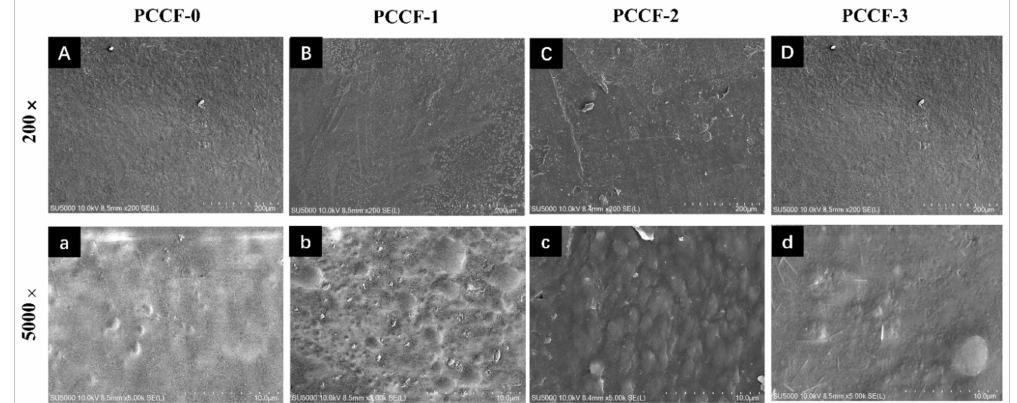
Figure 5. Microstructure and surface morphology of PCCF observed by SEM at a magnification of 200 × ( A – D ) and 5000 × ( a – d